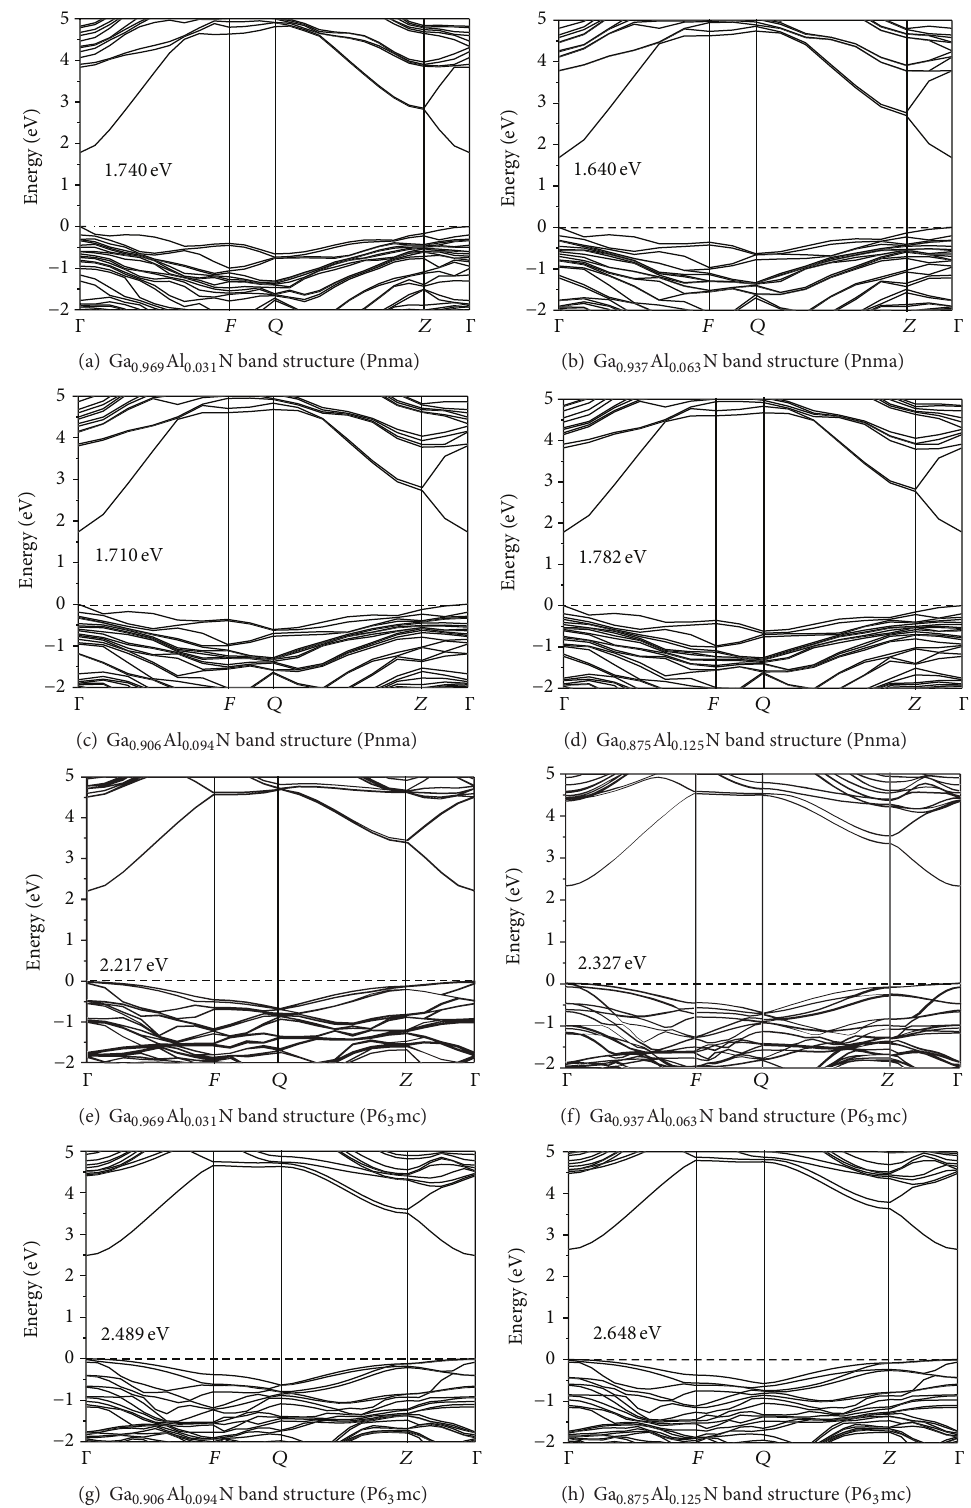
Figure 5: Electronic band structures of the Ga 0.969 Al 0.031 N (a), Ga 0.937 Al 0.063 N (b), Ga 0.906 Al 0.094 N (c), and Ga 0.875 Al 0.125 N (d) for Pnma-GaN at ambient pressure. Electronic band structures of the Ga 0.969 Al 0.031 N (e), Ga 0.937 Al 0.063 N (f), Ga 0.906 Al 0.094 N (g), and Ga 0.875 Al 0.125 N (h) for wurtzite-GaN at ambient